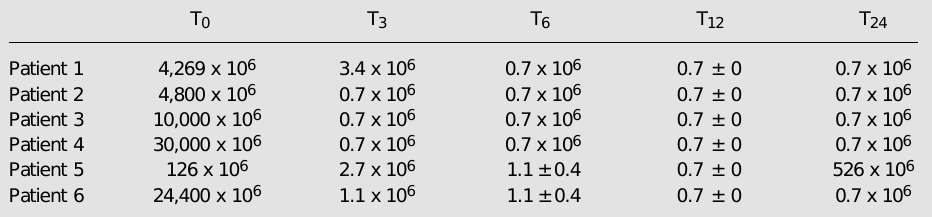
Table 2. Hepatitis B virus (HBV) DNA in HBV-infected renal transplant patients treated with lamivudine. T